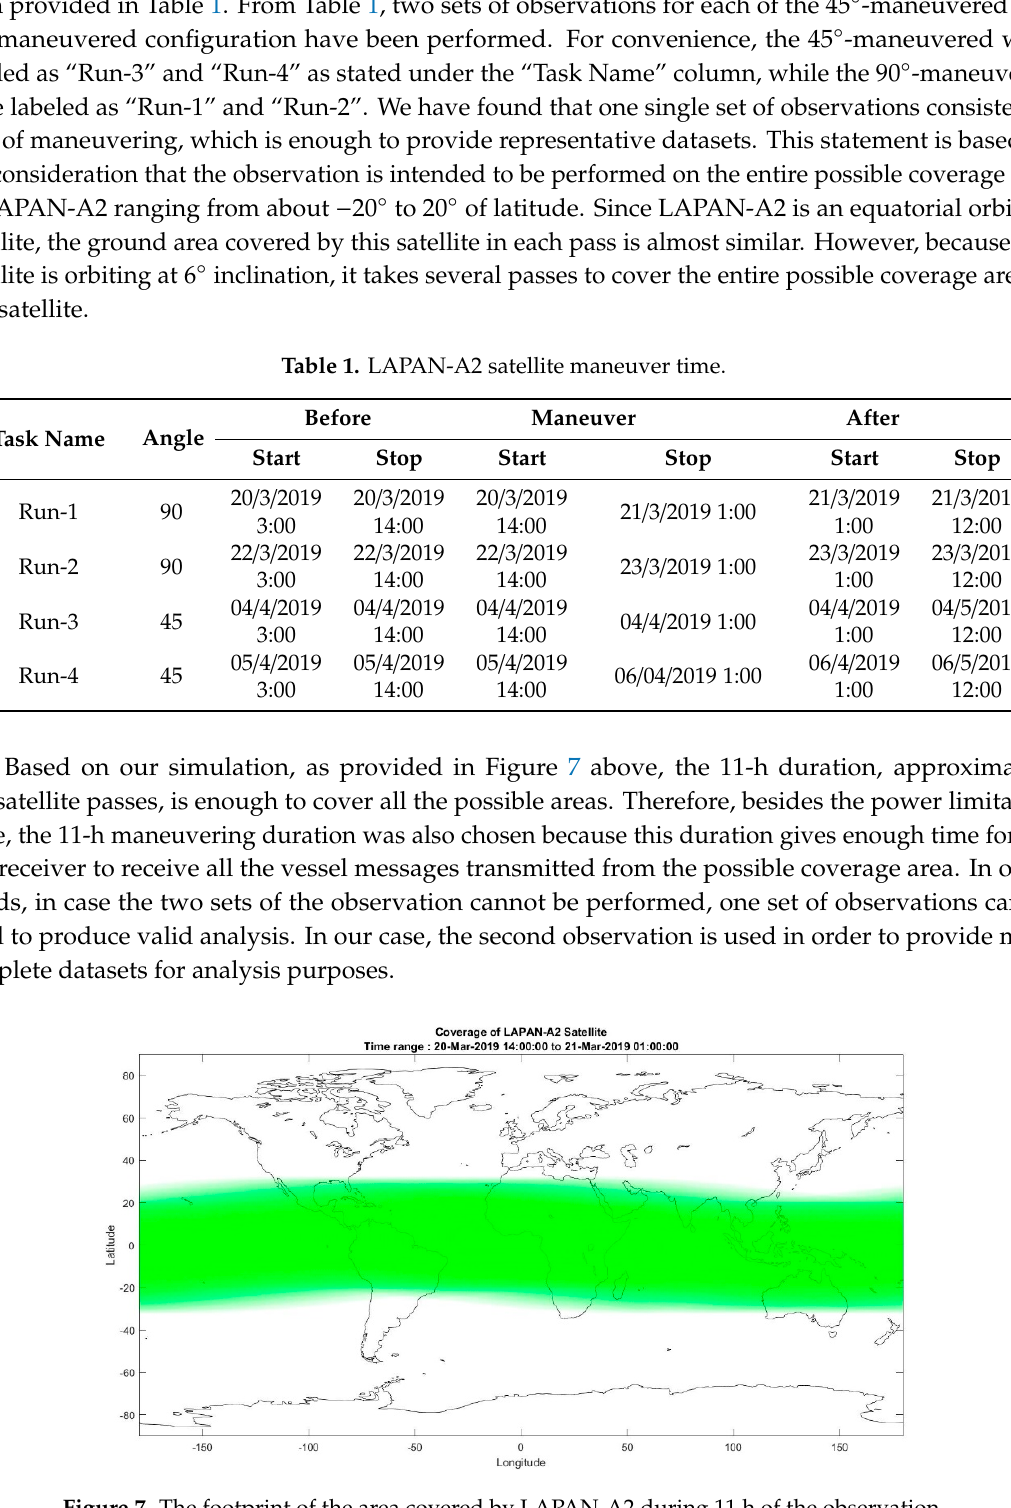
Figure 7. The footprint of the area covered by LAPAN-A2 during 11 h of the observation.